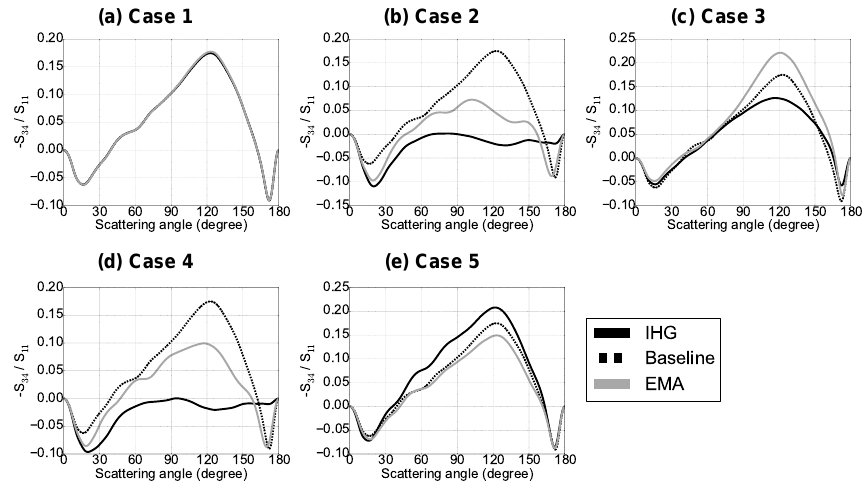
Figure 8. − S 34 /S 11 values for the inhomogeneous (IHG) and the homogeneous (EMA) versions of all five of the internal structure cases as a function of the scattering angle.